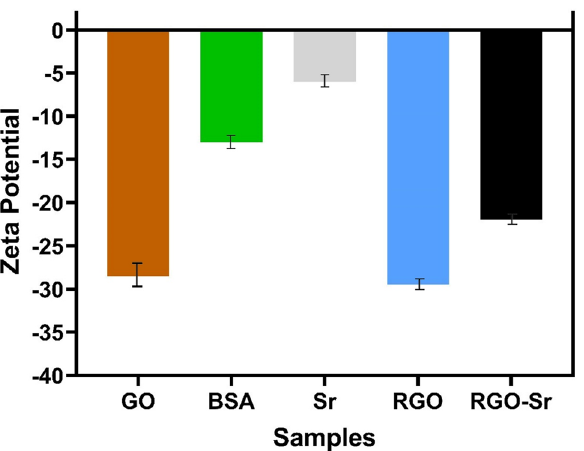
Figure 4. Zeta potential of GO, BSA, Sr, BSA-rGO (illustrated as RGO), and Sr-BSA-rGO (illustrated as